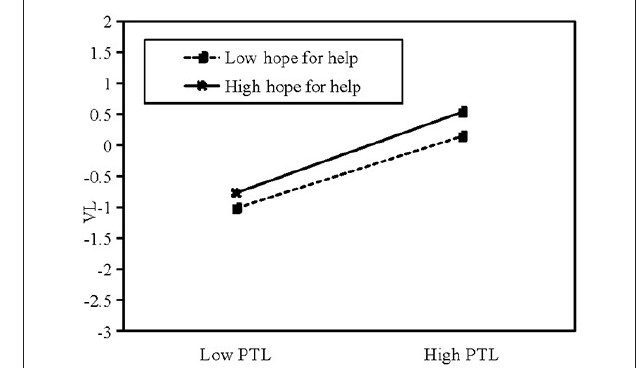
FIGURE 3 | The mediating effect of hope-for-help motivation on TL. PTL: length of patient’s textual messages.